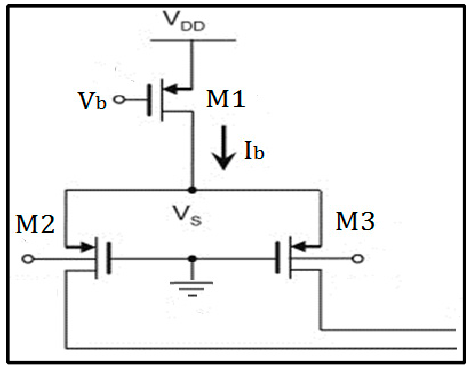
Figure 2. Bulk driven differential pair.